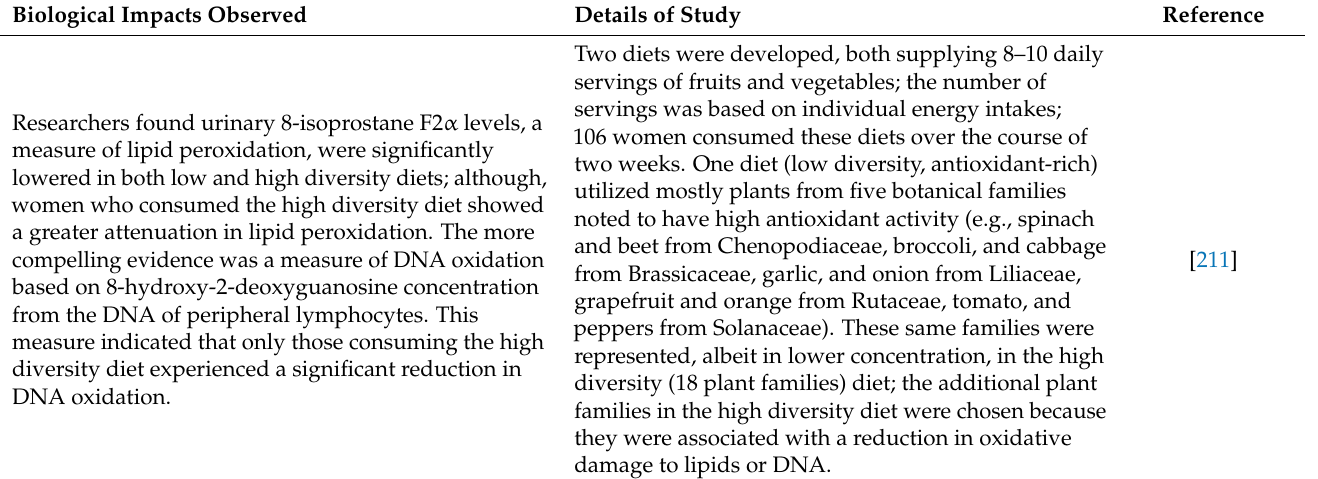
Table 8. Parameters and pertinent results from dietary trials examining health